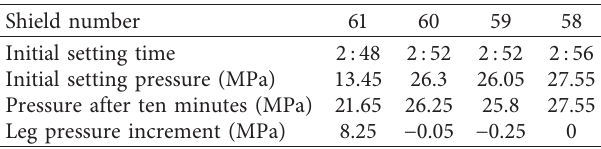
Table 3: Typical difference in leg pressure increment in the same